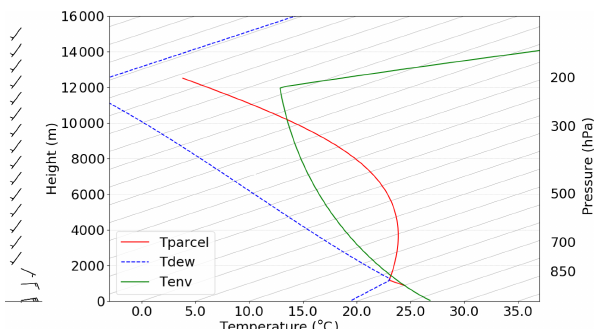
Figure 1. Thermodynamical profile based on Weisman and Klemp (1982) and wind profile after Rotunno et al. (1988), with adjust- ments. Temperature: solid green line; dew point: dashed blue line; convectively lifted undiluted parcel’s temperature: red line. The par- cel is initially lifted from the mixed layer (at z =